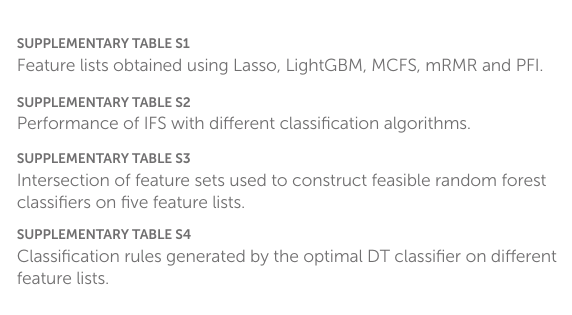
SUPPLEMENTARY TABLE S2 Performance of IFS with different classification algorithms. SUPPLEMENTARY TABLE S3 Intersection of feature sets used to construct feasible random forest classifiers on five feature lists. SUPPLEMENTARY TABLE S4 Classification rules generated by the optimal DT classifier on different feature